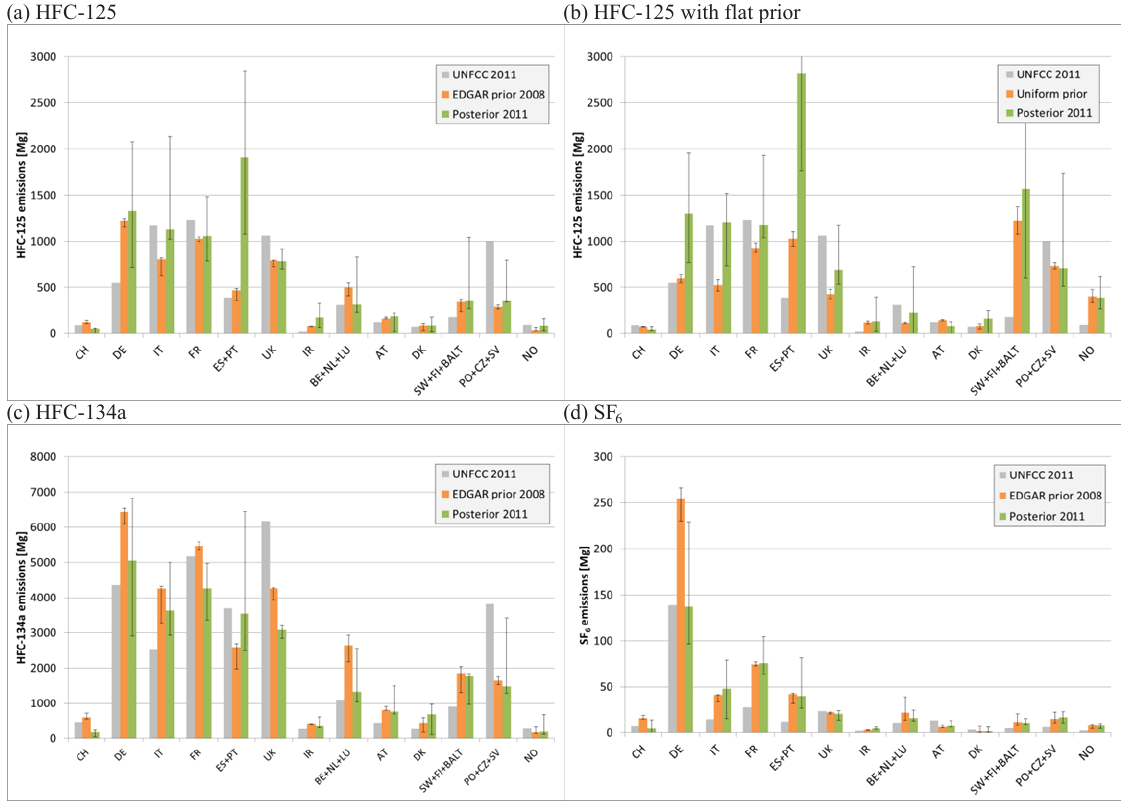
Figure 13. Median country-aggregated posterior emissions for (a) HFC-125 (experiment M1), (b) HFC-125 with flat prior (experi- ment FLAT), (c) HFC-134a (experiment M2), and (d) SF 6 (experiment M3). Uncertainty bars denote the range between minimum and maximum estimate of the four